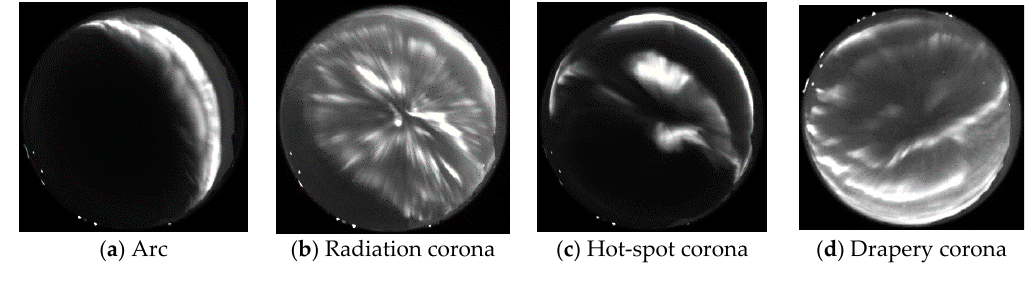
Figure 2. The four classes of auroras.